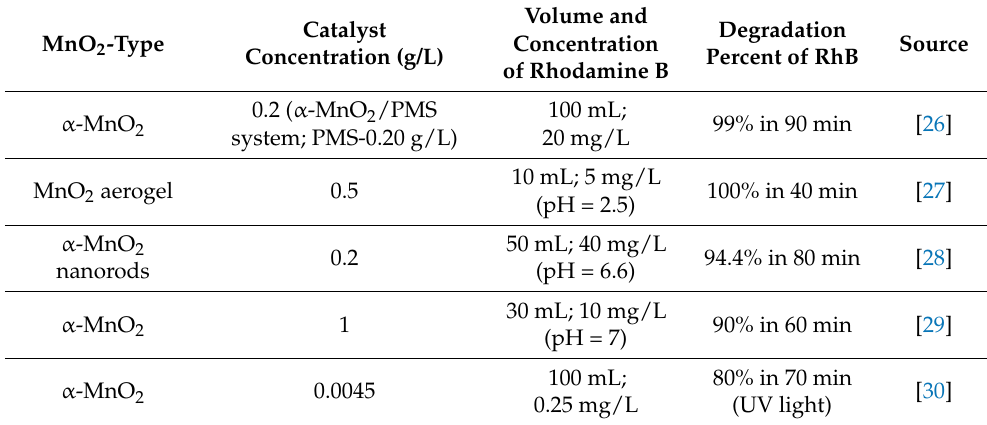
Table 1. Degradation of RhB over manganese dioxide using various experimental conditions. Volume and Catalyst Concentration MnO 2 -Type Concentration (g/L) of Rhodamine B